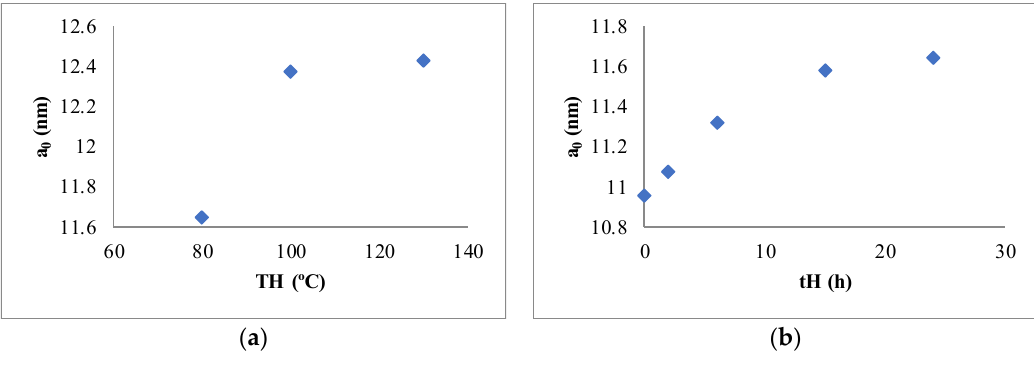
Figure 3. Evolution of the unit cell parameter with the variables of the study—80, 100, and 130 °C ( a ) and 0, 2, 6, 15, and 24 h ( b ).